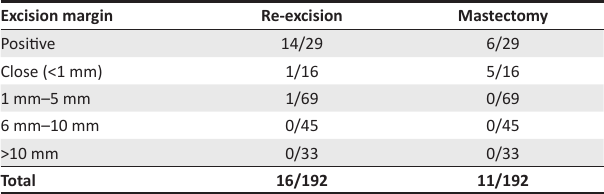
FIGURE 1: Bar chart showing the percentages of the excision margins. TABLE 2: Excision margins and procedure after initial wide local